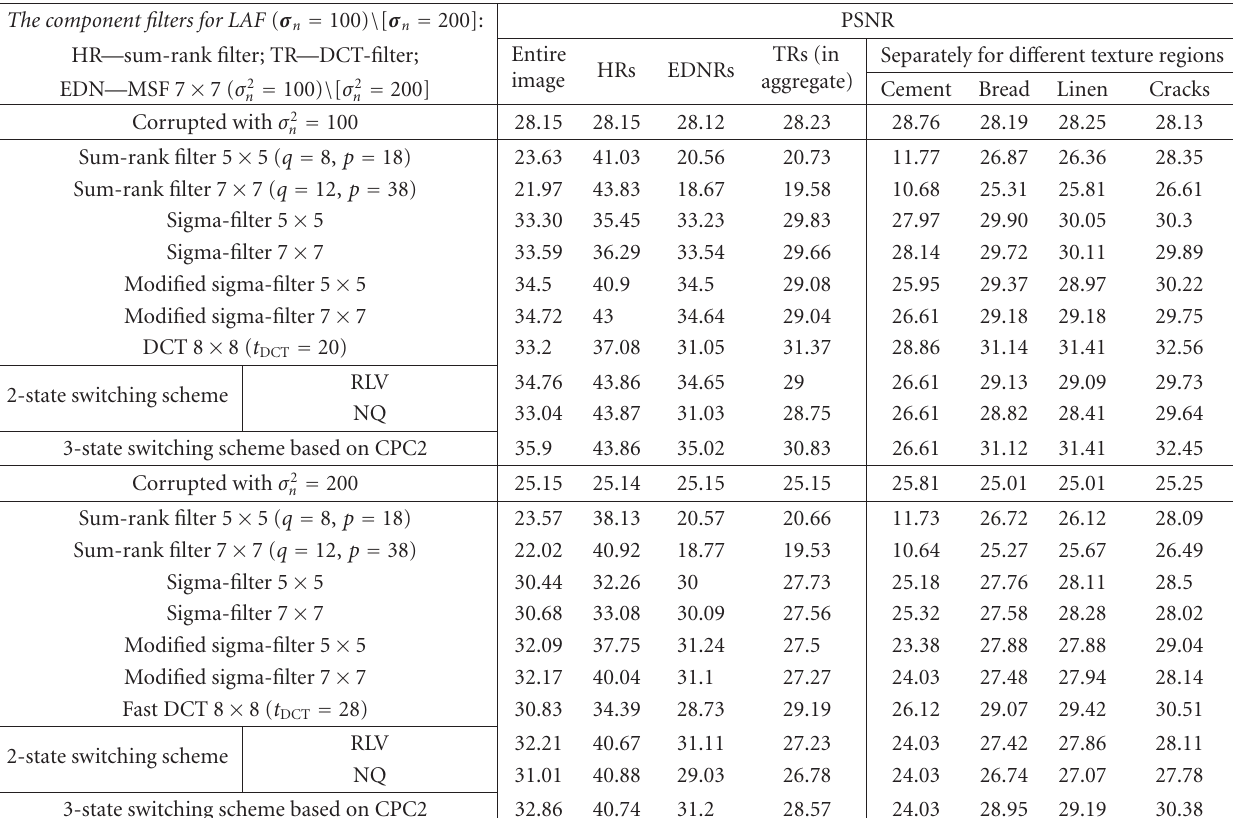
Table 3: Aggregate and local PSNR values for nonadaptive and locally adaptive filters for the test image in Figure 1. The additive Gaussian noise with σ 2 n = 100 and with σ 2 n = 200 has been added to this image (Figure 8a). The component filters for LAF ( σ n = 100) \ [ σ n =